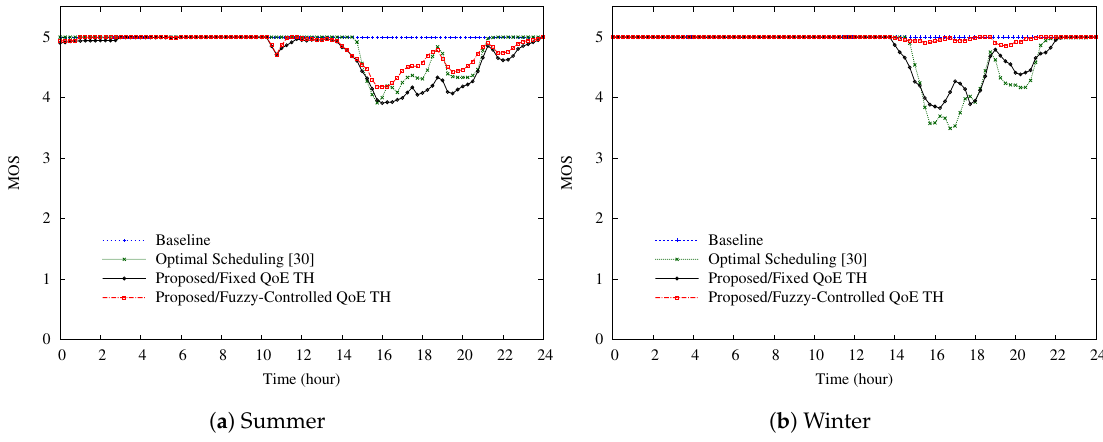
Figure 10. Comparison of user’s